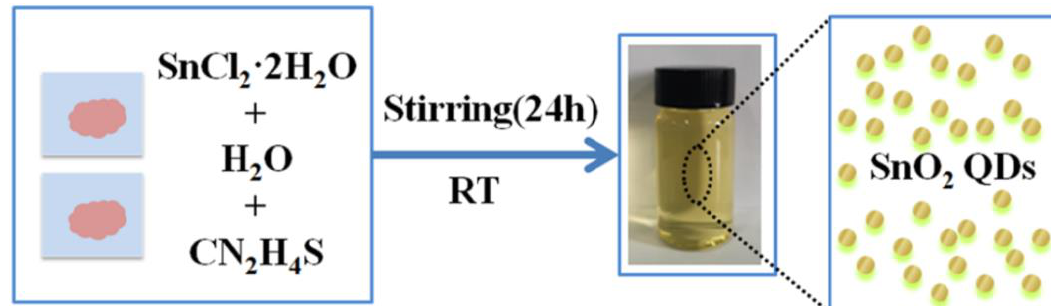
Figure 2. Colloidal synthesis of SnO 2 QDs [35], Copyright 2020, ACS.